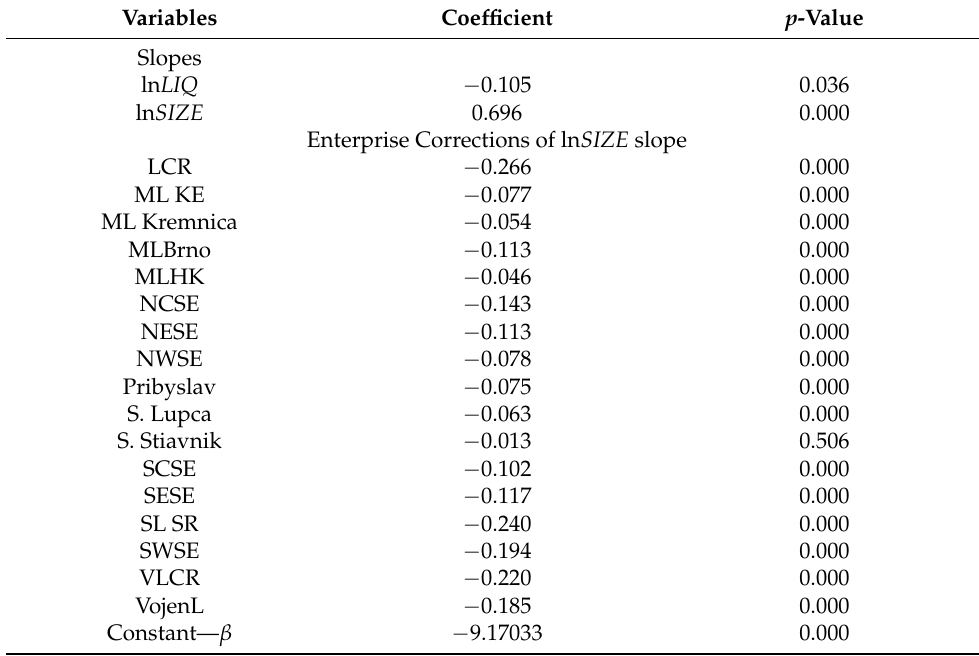
Table 8. Panel data results for model (2) with significant slope (elasticity) corrections: α = 0.05; R =